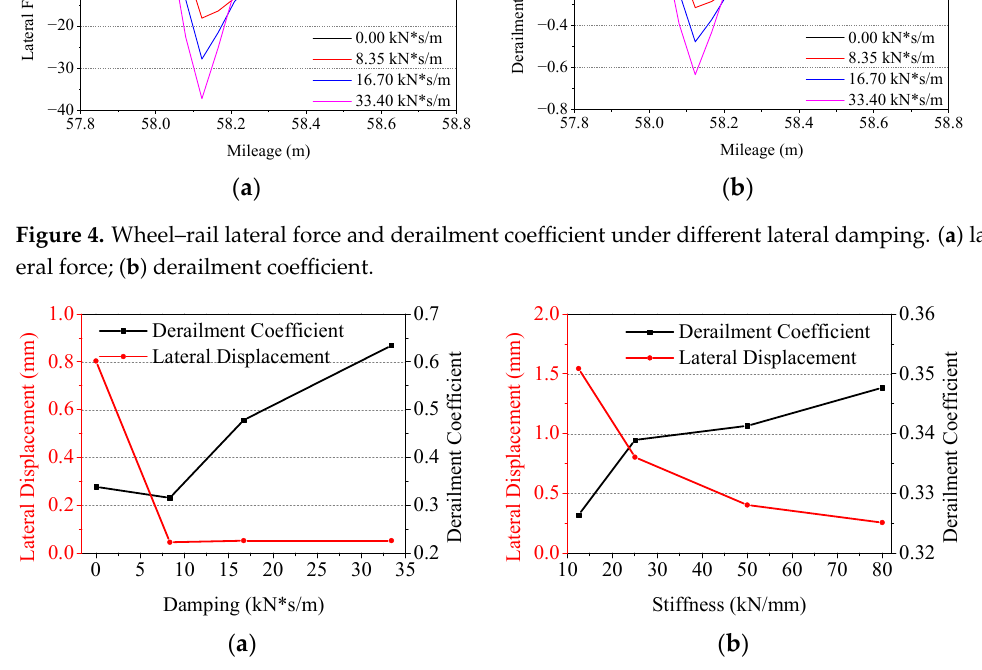
Figure 5. Chart of extreme values of calculation results under different lateral damping and stiffness conditions. ( a ) Results under different damping conditions; ( b ) results under different stiffness con- ditions.